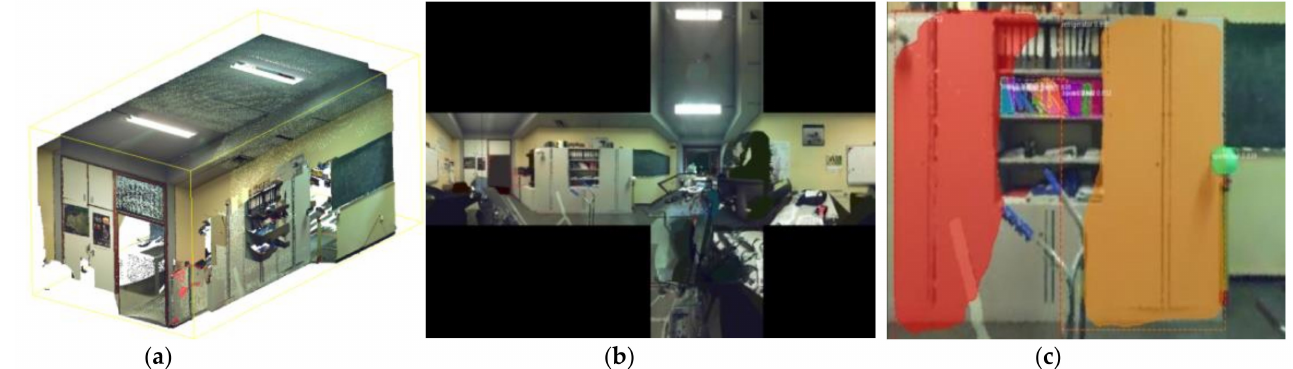
Figure 28. Instance segmentation of the cubemap right facet (the office scene): ( a ) point cloud; ( b ) cubemap; ( c ) instance segmentation on the cubemap right facet.